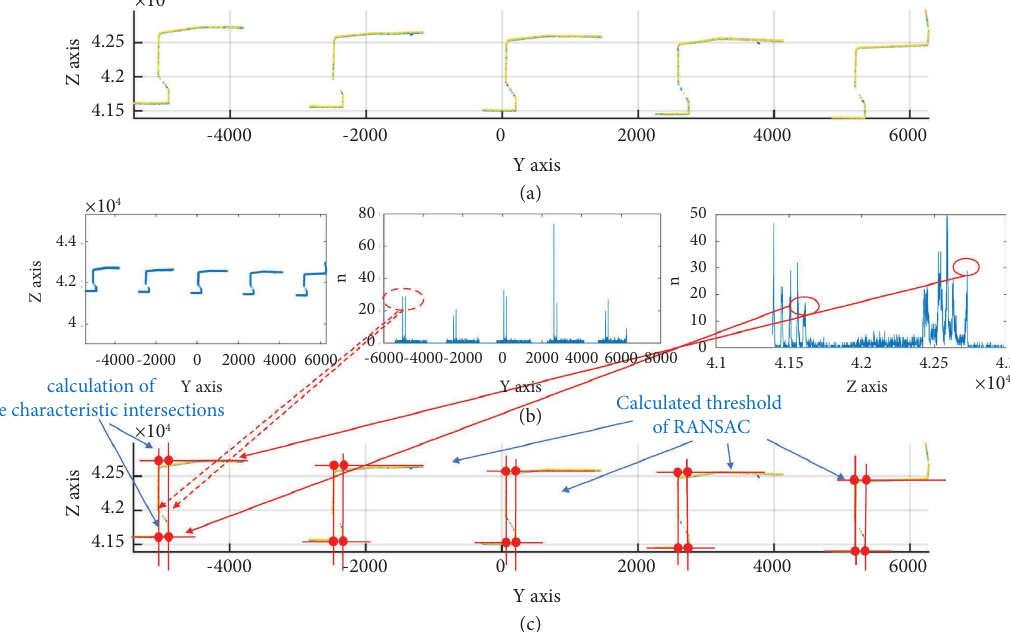
Figure 8: Illustrations of characteristic intersections for T-beam: (a) original point clouds, (b) calculated threshold of RANSAC, and (c) calculation of the characteristic intersections.